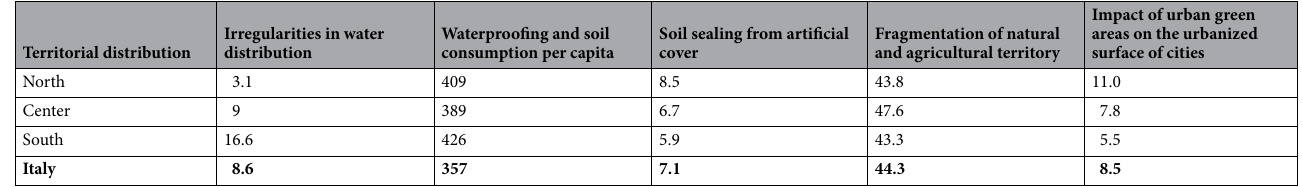
Table 5. M2C4 indicators—Protection of land and water resources by territorial distribution (year 2019). Source : our elaboration on SDGs. National values are in